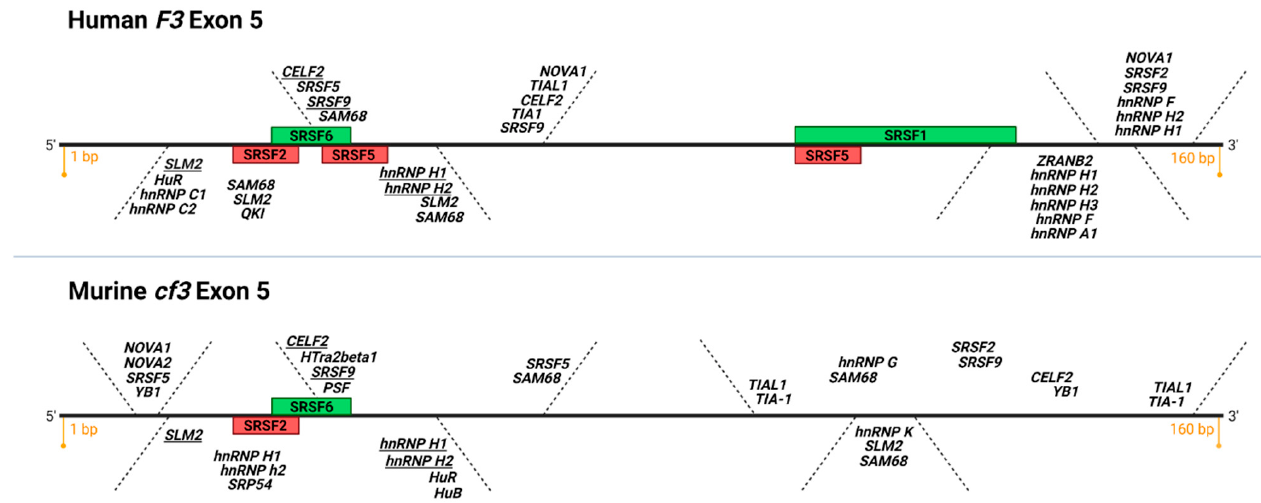
Figure 3. Putative and confirmed RNA binding protein motifs on human and murine exon 5 of TF. Depicted is a diagram of F3 and cf3 exon 5, 160 bp each, top and bottom, respectively (adapted from SpliceAid [69]). Green boxes: functionally validated SR protein binding sites that promote exon 5 inclusion (exonic splicing enhancers, ESE), red boxes: functionally validated SR protein binding sites that promote exon 5 exclusion (exonic splicing silencers, ESS). Note the conservation of functional SRSF2 ESS and SRSF6 ESE in human and mouse exon 5 (K.M. and V.Y.B., unpublished data). In italics are putative recognition consensus motifs for various classes of RNA binding proteins; consensus motifs present in human and mouse exon 5 are underlined. Image created with BioRender.com (Accessed on 9/13/21).